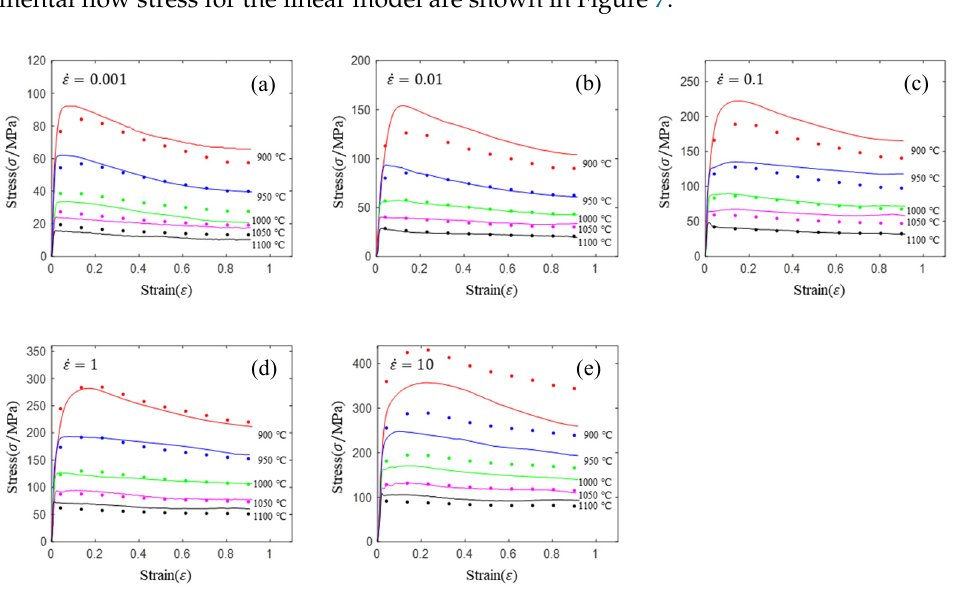
Figure 7. Comparison of prediction flow stress and experimental flow stress for linear model: ( a ) 0.01 s − 1 ; ( b ) 0.1 s − 1 ; ( c ) 1 s − 1 ; ( d ) 10 s − 1 ; ( e ) 10 s − 1 .